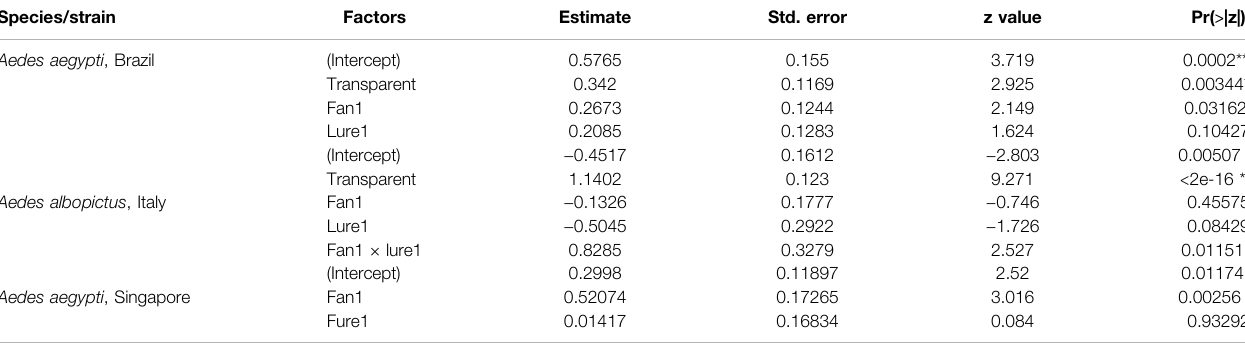
TABLE 1 | Fixed effects of the internal tube color and addition of lure and fan (or none) on the escape rates of Aedes aegypti (Brazilian strain), Aedes albopictus (Italy, Rimini strain), and Aedes aegypti (Singaporean strain) males. Species/strain Factors Estimate Std. error z value Pr( > |z|) Aedes aegypti , Brazil